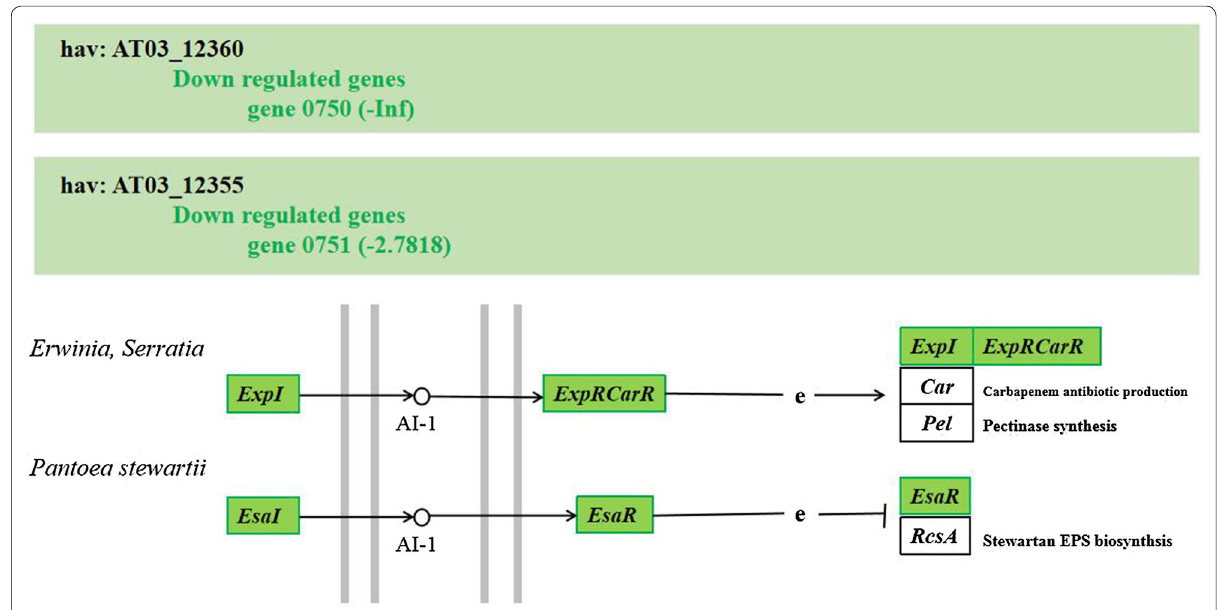
Fig. 4 KEGG “quorum sensing” pathway based on RNA high-throughput sequencing analysis. Proteins appearing in the green boxes are down-regulated at the mRNA